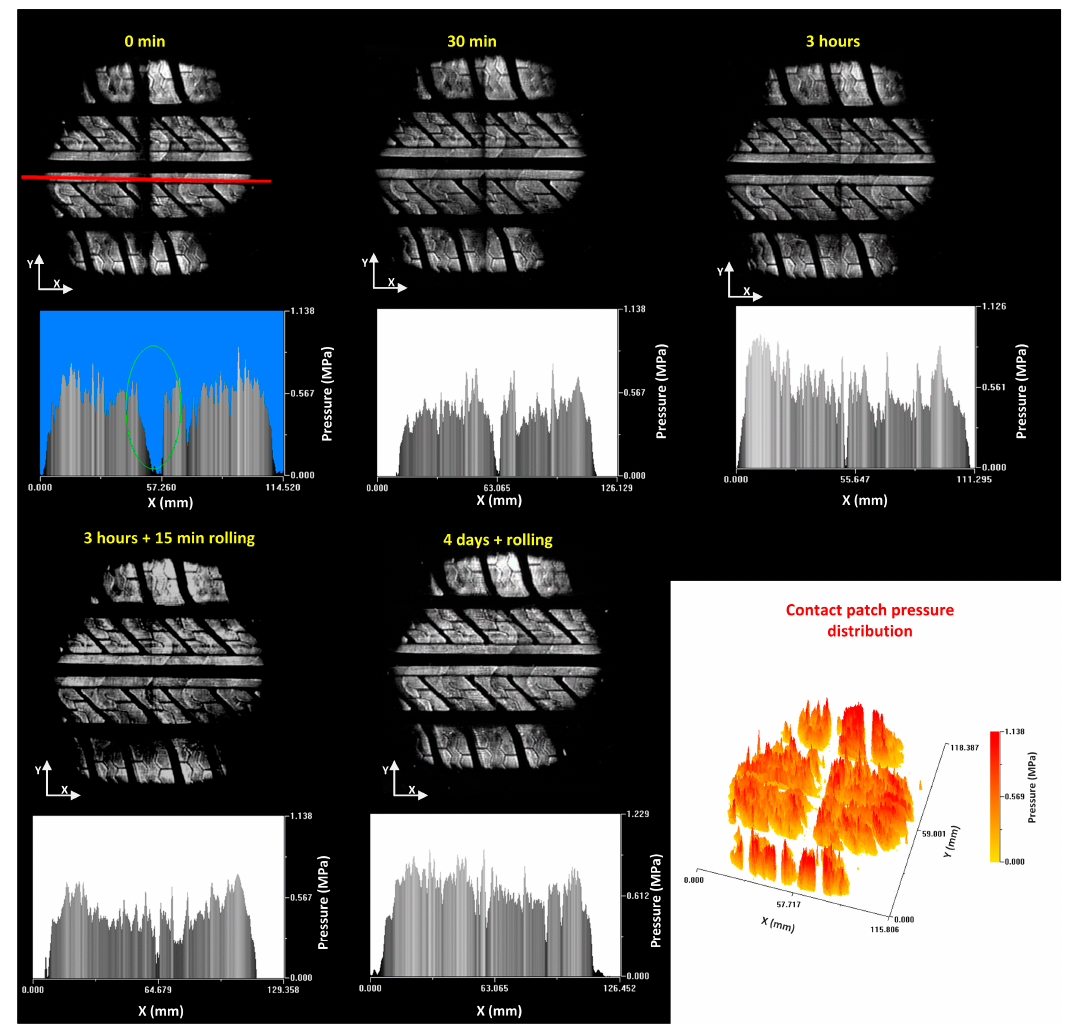
Figure 31. Pressure distribution, longitudinal profiles and contact patch pressure distribution.